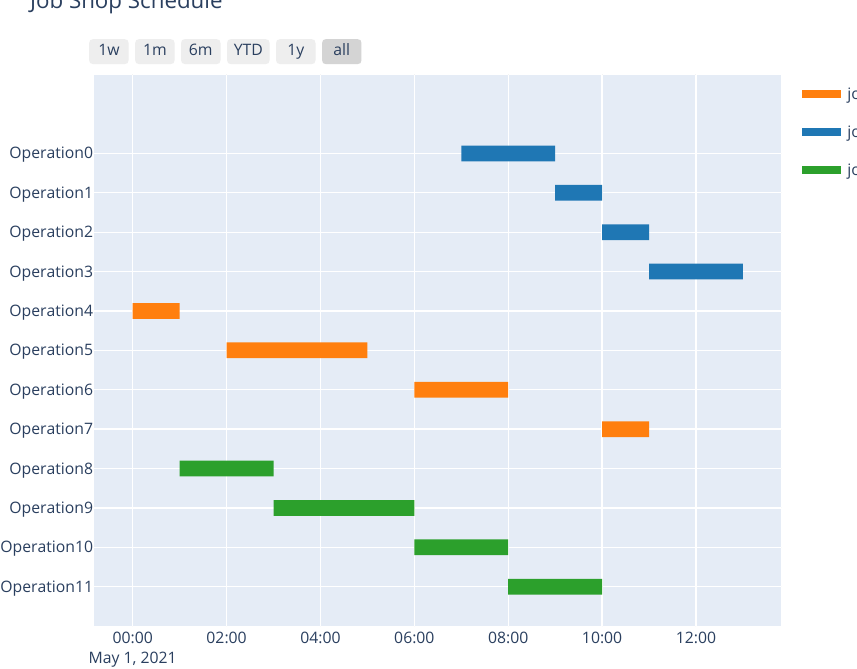
Figure 7. Job-Shop Schedule obtained with the Fujitsu Digital